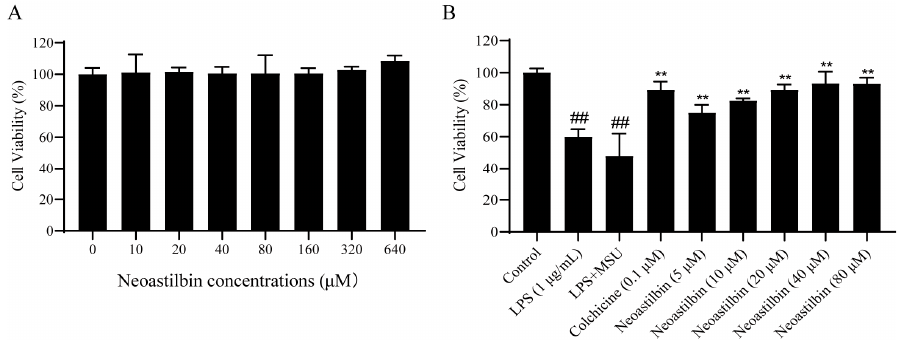
Figure 1. Effect of neoastilbin on cell viability in THP-1-derived macrophages. ( A ) THP-1-derived macrophages stimulated with various concentrations of neoastilbin. ( B ) The protective effect of neoastilbin for MSU-stimulated THP-1-derived macrophages. Data in the figures represent the means ± SD; significant differences among different groups are indicated as ## p < 0.01 vs. control group, ** p < 0.01 vs. LPS + MSU group ( n =